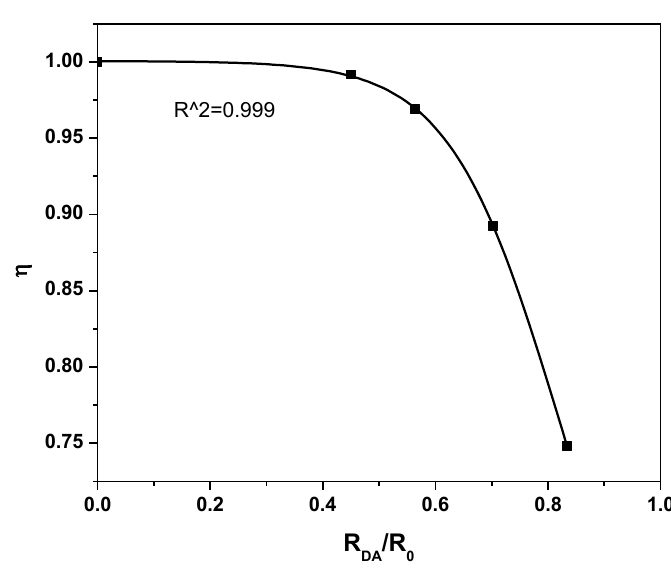
/ R / MEH-PPV hybrid thin films. DA 0 for 0-D Cs 4 PbBr 6